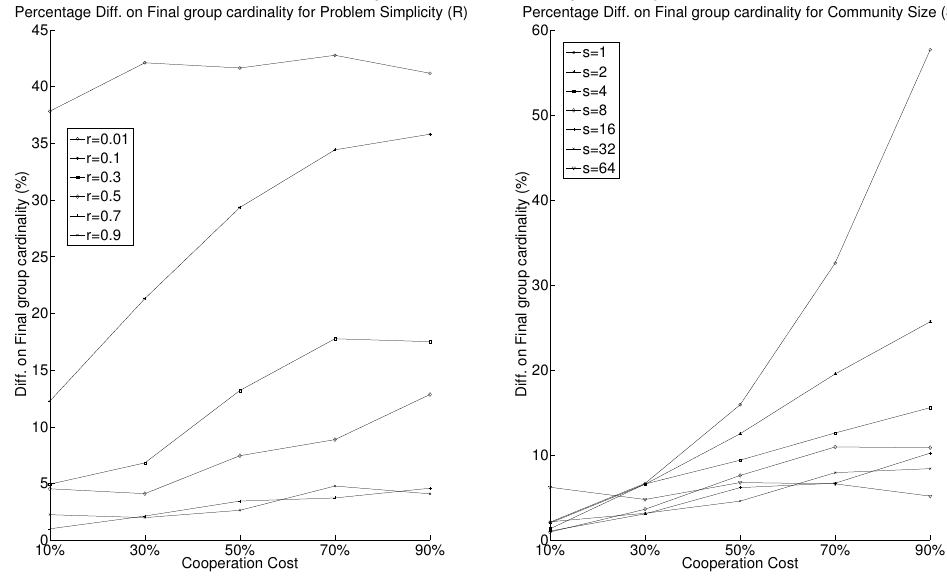
Figure 1. Percentage differences of the final group cardinality (i.e., the maximum complexity of the problem-solved in the past) in comparison to the cost of cooperation, for each problem simplicity ( left plot) and for each group size ( right plot).